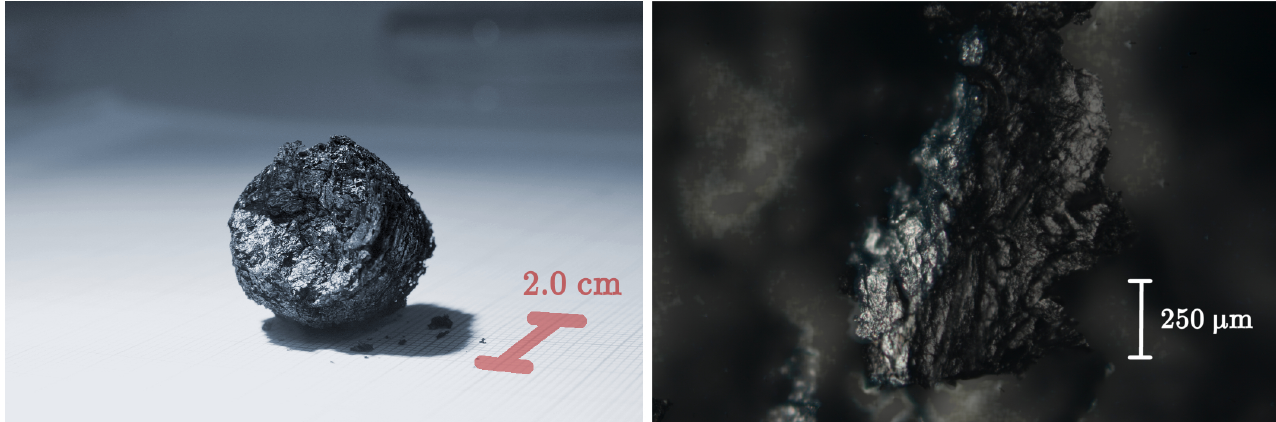
Figure 1. ( Left panel ): photo of the whole GS, investigated in this study, taken by a camera equipped with a macro lens. ( Right panel ): fragment of the GS observed by optical microscopy at a magnification of 5 × . Eight images, each focussed at a different depth, have been combined together by a photo stacking technique to overcome the intrinsically 3D nature of the material and the reduced depth of field of the